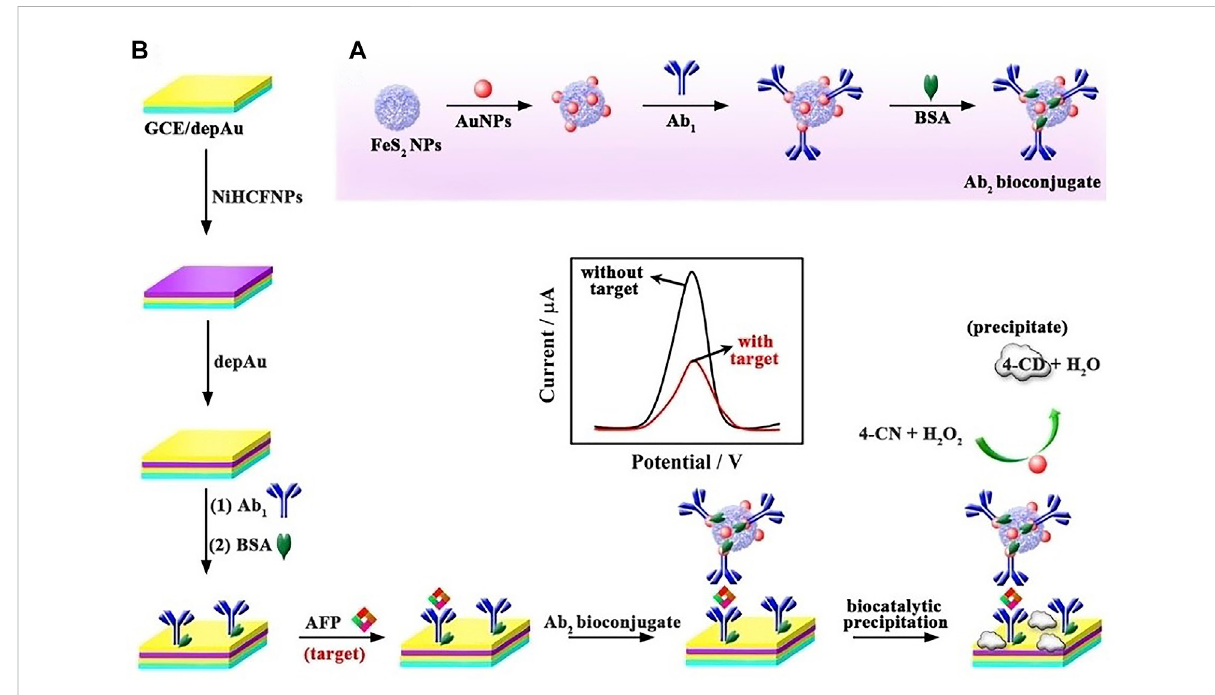
FIGURE 2 (A) Preparation of the FeS 2 -AuNPs-Ab 2 bioconjugates and (B) sandwich model making process for testing AFP. Reproduced with permission from Ref. (Zhang et al., 2019). Copyright © 2019 Wiley-VCH Verlag GmbH and Co. KGaA,